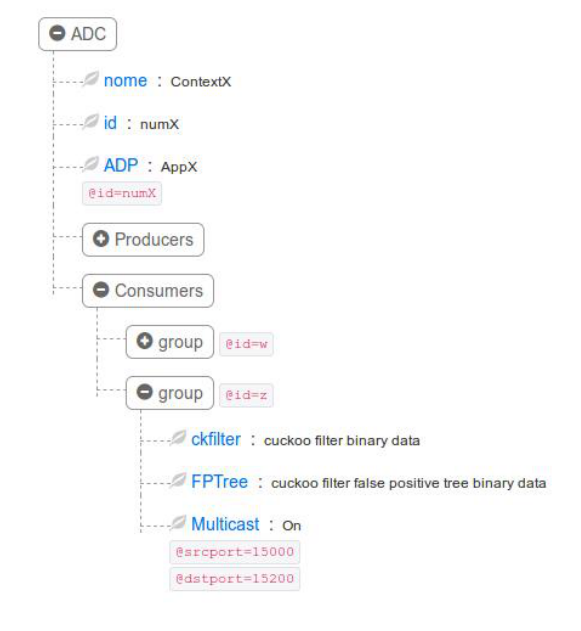
Figure 2. ADC Specification and multicast group.